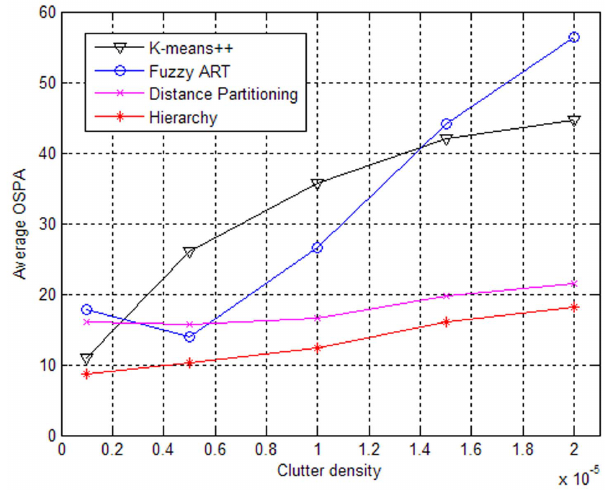
Figure 4. Performances of partitioning algorithms versus clutter